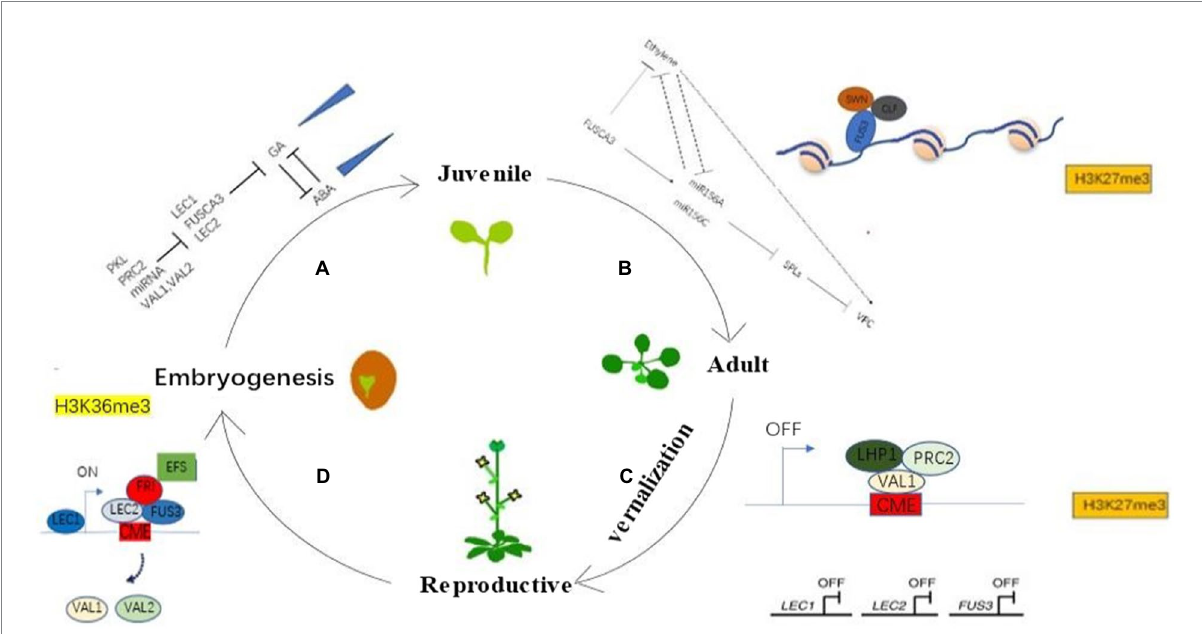
FIGURE 1 LEAFY COTYLEDONs connect different growth stages of plants and complete the generation cycle through epigenetic modification and mediating phytohormonal signaling. (A) LEAFY COTYLEDONs regulate the transition from embryogenesis to juvenile stage. PKL , PRC2 , miRNA, and VAL1/VAL2 inhibit the expression of LEAFY COTYLEDONs to inhibit the GA signaling pathway. GA is antagonistic to ABA, and the expression of GA increases continuously, whereas ABA shows the opposite expression pattern during this stage. (B) LEAFY COTYLEDONs regulate the transition from juvenile to adult stage. There are potentially two pathways of how LEAFY COTYLEDONs regulate the transition from juvenile to adult stage. One is that FUS3 promotes VPC by recruiting chromatin repressors such as SWN and CLF for chromatin modification of miR156 to inhibit the expression of miR156 and then promote the expression of downstream SPLs . Another is that FUS3 regulates VPC by participating in the ethylene signaling pathway, and there may be a cross-talk between these two pathways. (C) Perennials experience vernalization from juvenile to adulthood. VAL1/2 competes with LEAFY COTYLEDONs for binding to the FLC cold memory element CME, and VAL1/2 shuts down FLC expression by recruiting PRC2 and LHP1 for chromatin modification of FLC , as LEAFY COTYLEDONs shut down expression during this period. (D) Plants enter embryonic stage after fertilization. The LEAFY COTYLEDONs are expressed sequentially, and the plant enters a new life cycle by recruiting active chromatin modifiers such as FRI and EFS to activate the expression of FLC and a series of other genes such as miR156 . VAL1/2 are suppressed during this